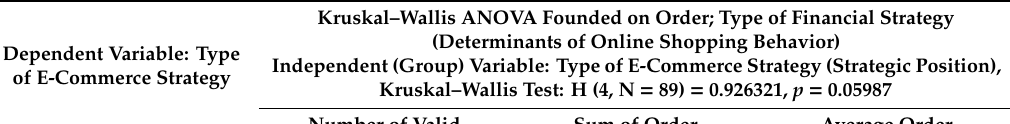
Table 7. Kruskal–Wallis ANOVA founded on order; Example: Type of financial strategy according to type of e-commerce strategy. Source: own processing (in the Statistica software).